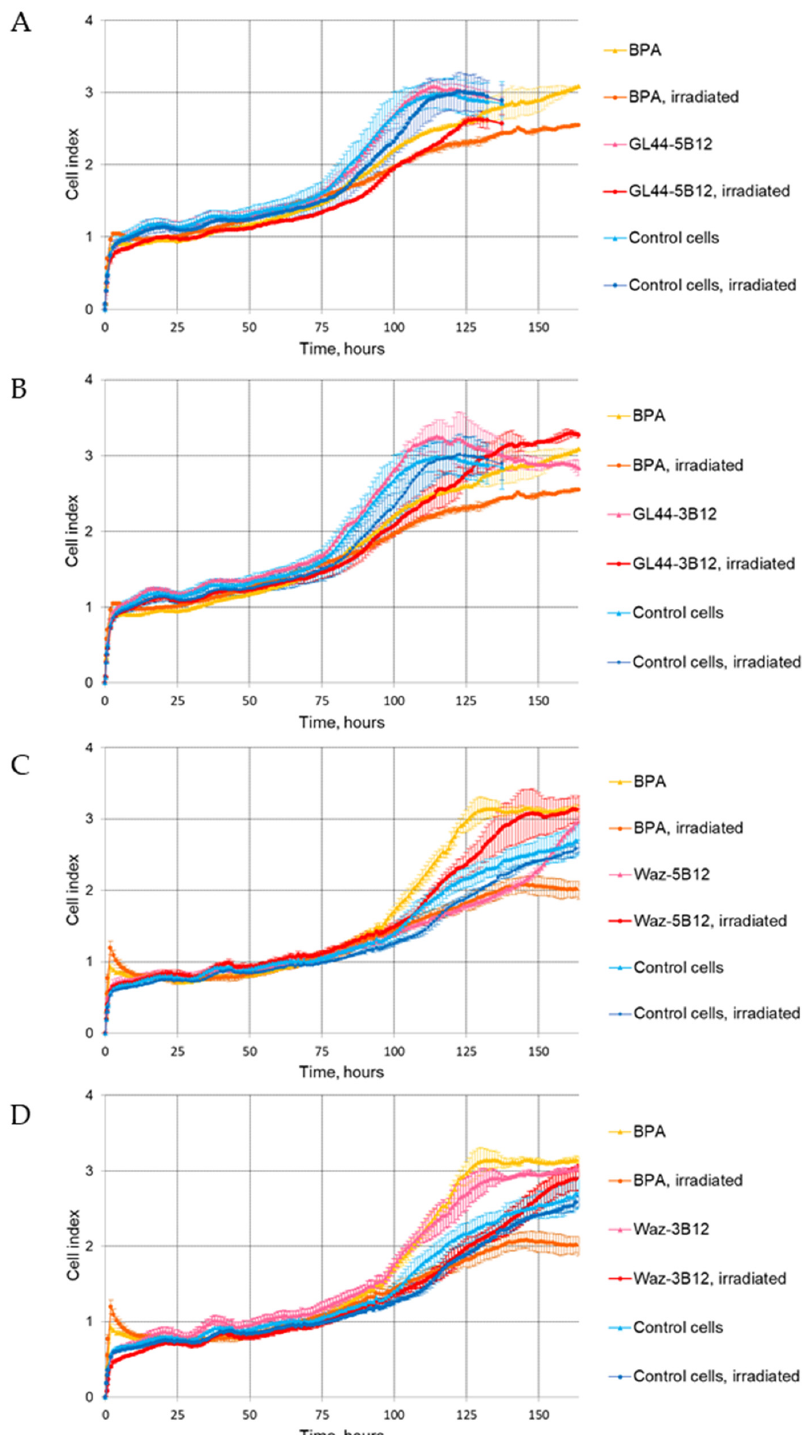
Figure 2. Dynamic RTCA monitoring of cell adhesion and proliferation of U ‐ 87 MG human glioblastoma cells after pre ‐ treatment with boron ‐ containing 2 ′‐ F ‐ RNA conjugates GL44 ‐ 5B12 ( A ), GL44 ‐ 3 ‐ B12 ( B ), Waz ‐ 5B12 ( C ) or Waz ‐ 3B12 ( D ), with or without subsequent irradiation with epithermal neutrons. Irradiated cells pre ‐ treated with 10 B ‐ BPA were used as a positive control. Control cells—U ‐ 87 MG cells that were not incubated with any boron compounds. Parametric data are expressed as mean ± standard deviation (SD). Each experiment was repeated at least two times due to the limitation of the number of wells in the E ‐ Plate.